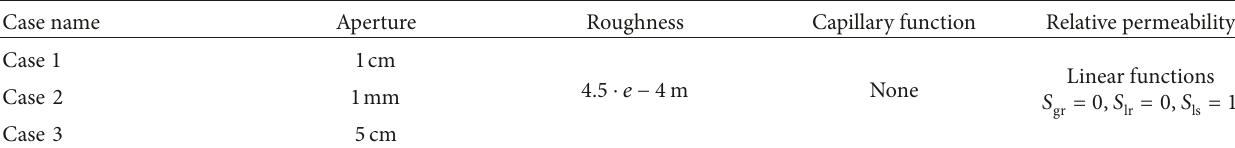
Table 2: Parameters of fracture zone in momentum models.